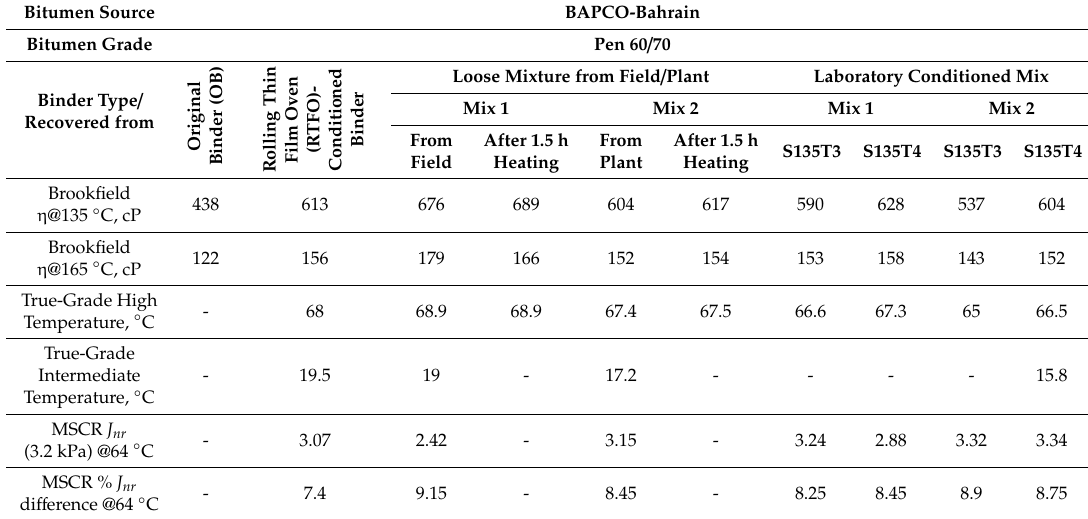
Table 6. Summary of binder test results for unmodified mixtures (mixtures 1 and 2).